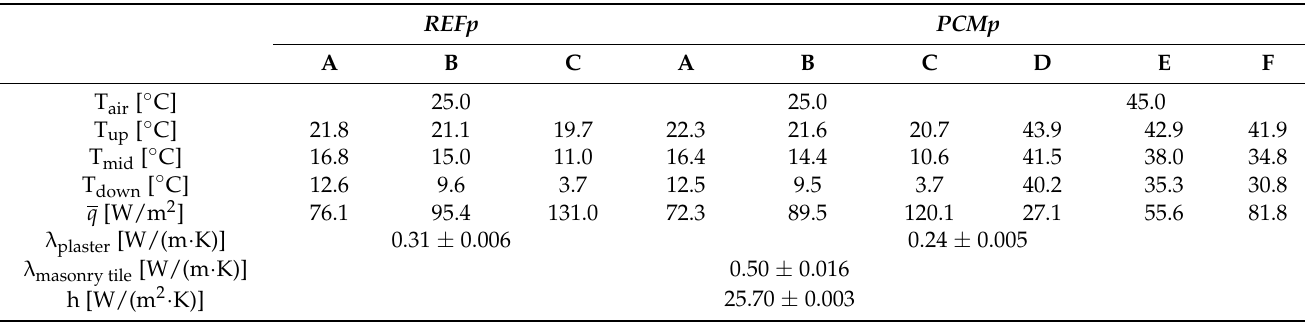
Table 3. Temperature and heat flux values obtained from the steady-state